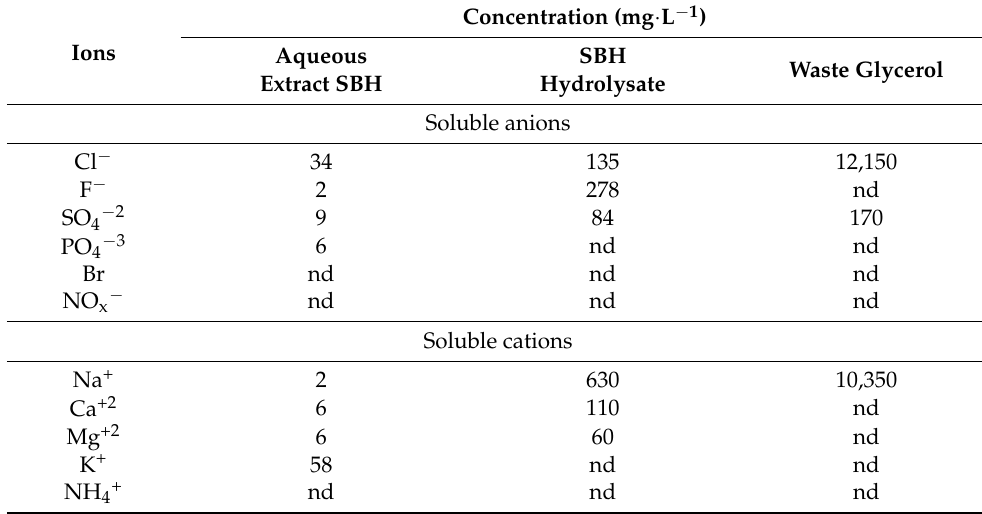
Table 2. Quantification of ions in the aqueous extract of SBHH and in the WG.